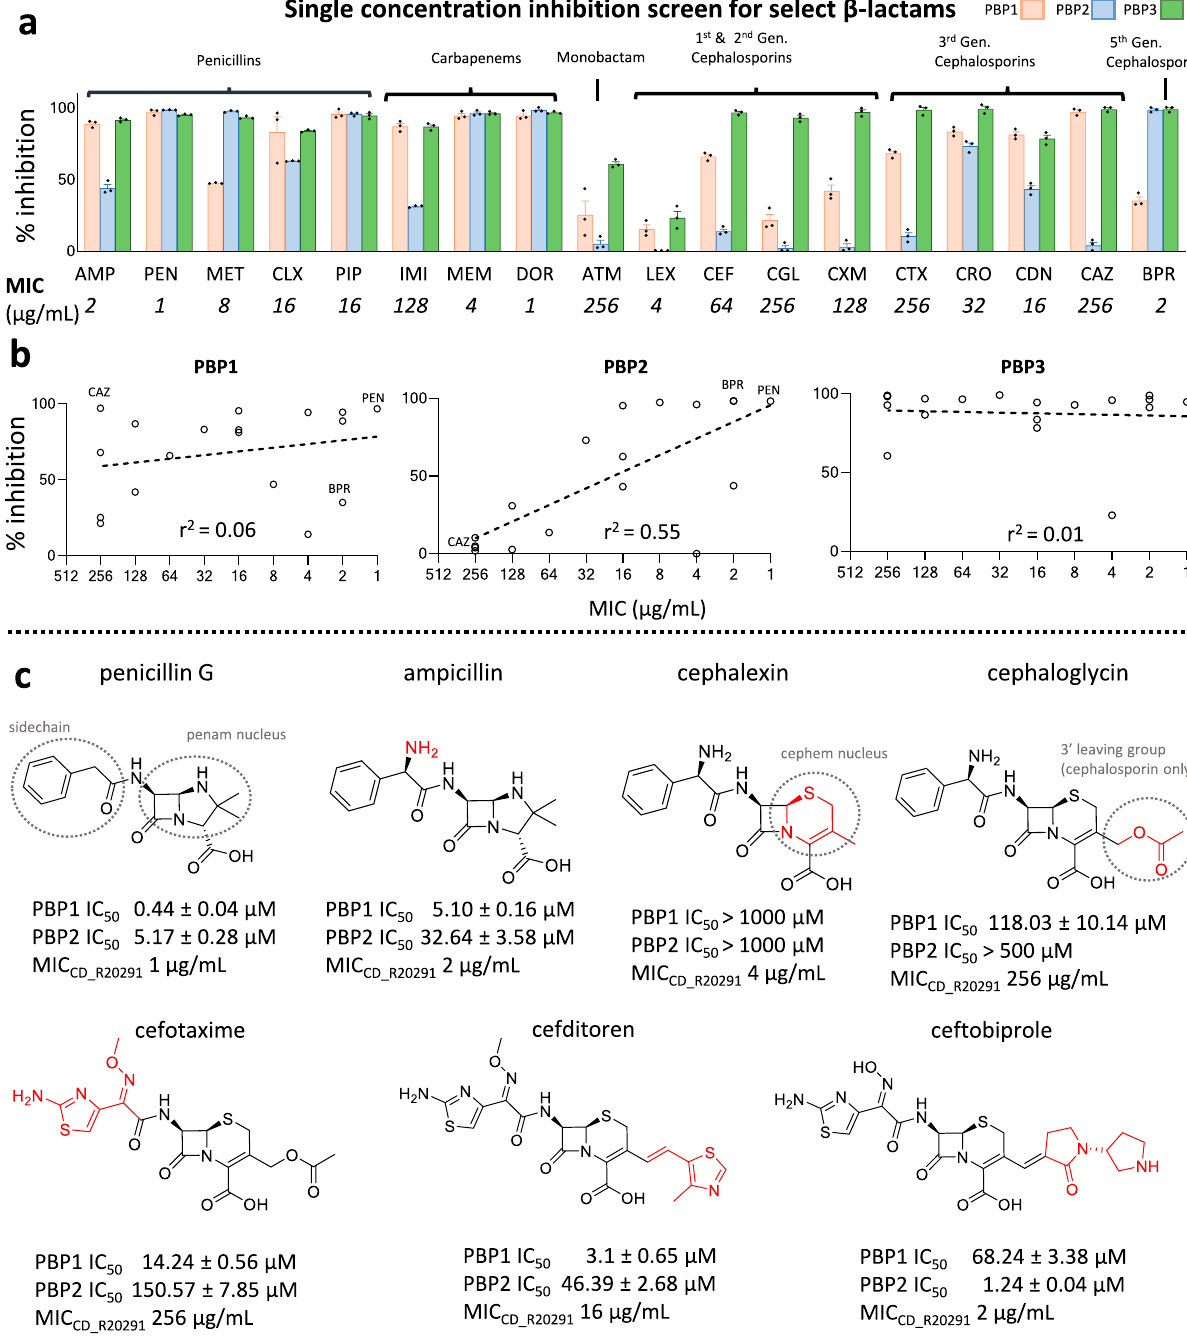
Fig. 1 | Biochemical and cellular inhibition pro fi le of β -lactam antibiotics againstmajorvegetativeC.dif fi cileTPasePBPs.a Select β -lactamsweretestedat 25 µ M for their ability to compete with the binding of the fl uorescent penicillin, bocillin. Their % inhibition are shown as a bar graph where each color represents inhibition against PBP1 (orange), PBP2 (blue), and PBP3 (green). Data are reported asthemeanofthreeindependentexperiments±SEMwitherrorsbarsrepresenting SEM. Source data are provided as a Source Data fi le. The antibacterial inhibition (MIC) against C. dif fi cile is listed directly below it (mean MIC reported from three biological replicates). As seen, the cephalosporins, which are poor inhibitors, also havelowantibacterialpotency.Therelationshipbetweenantibacterialpotencyand biochemical inhibition is further illustrated in the scatterplot shown in panel b , where the log regression coef fi cient is listed. The high coef fi cient for